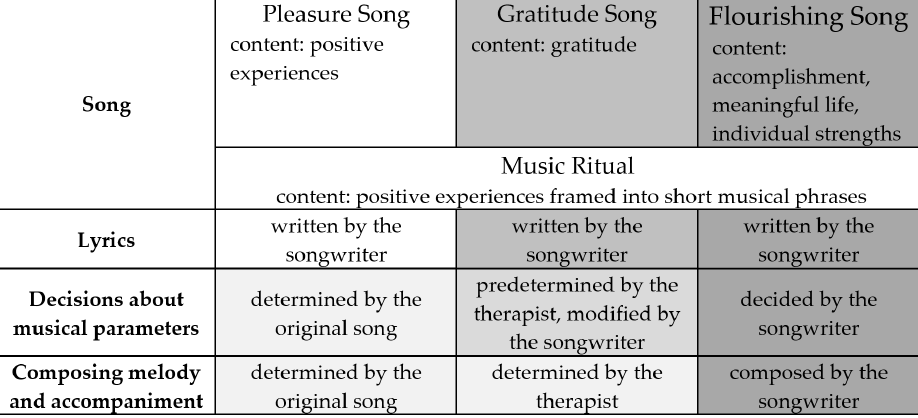
Figure 2. Elements of songwriting procedure.